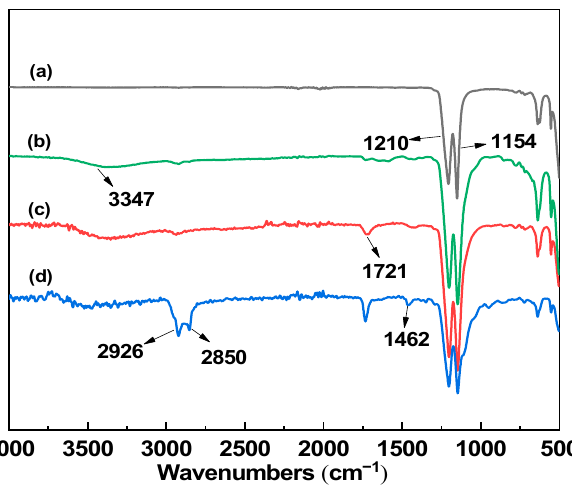
Figure 2. Infrared spectra of different PTFE microfiltration membranes: ( a ) M 0 ; ( b ) M- PVA5 ; ( c ) M- PVA5/CA2 ; ( d ) M- PEGML2/PVA5/CA2 .